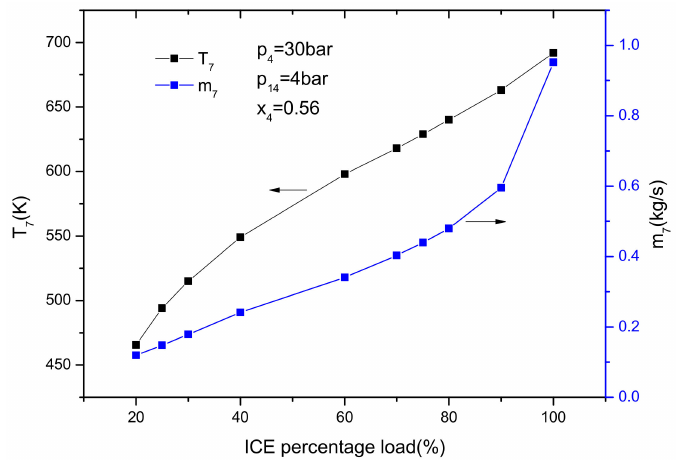
Figure 2. Effects of ICE percentage load on T 7 and m 7